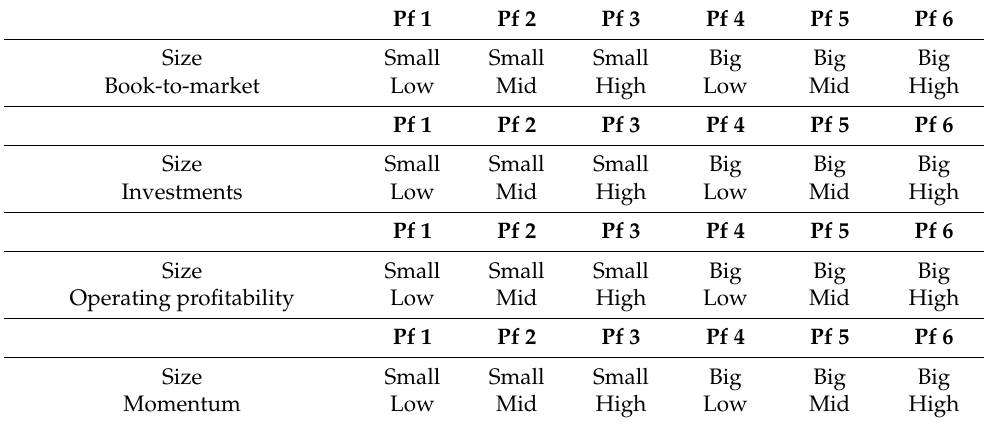
Table 8. Combination portfolios based on size and other